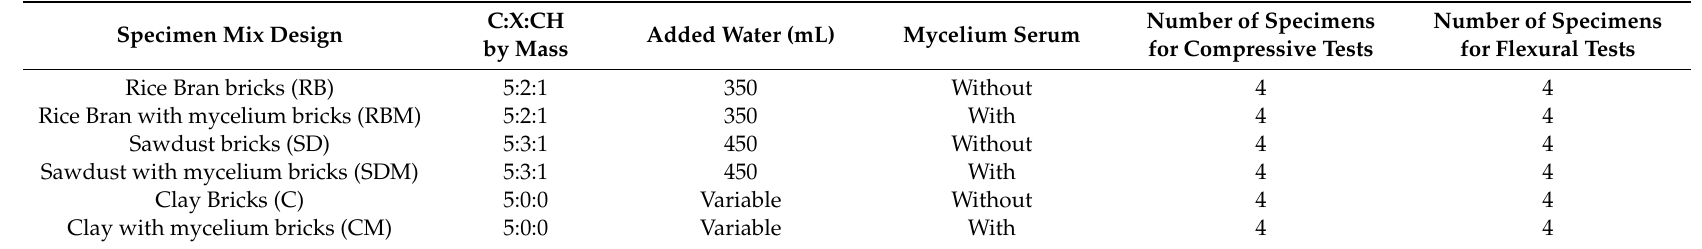
Table 1. Composition and number of